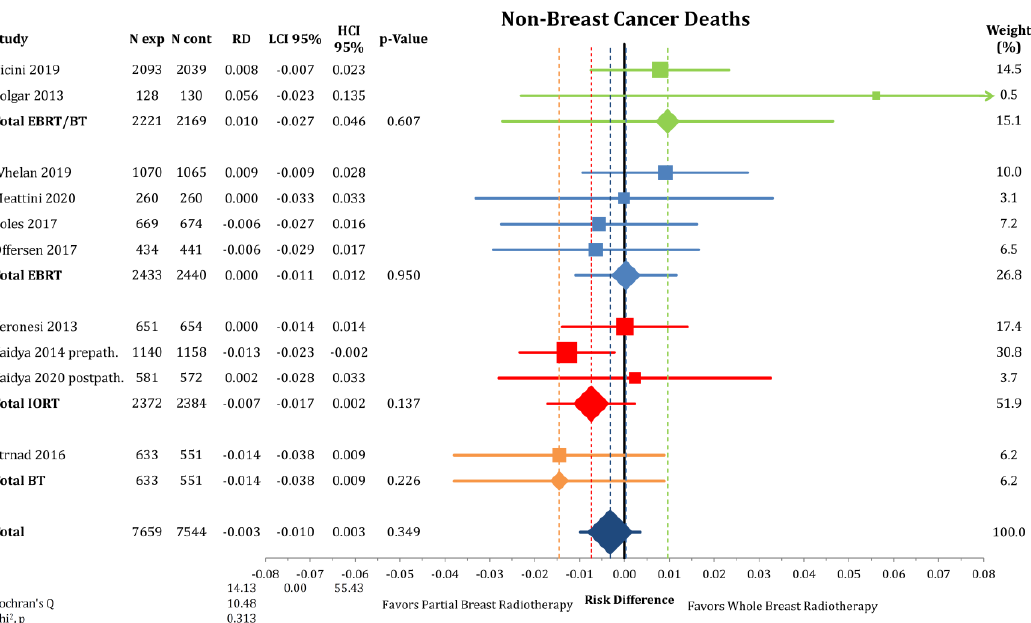
Figure 4. Comparison of breast cancer-specific survival by risk difference between partial- and whole breast radiation using a forest plot and the inverse variance heterogeneity model. Trials are grouped by radiation technique. Quadrats and diamonds represent individual trials and pooled effect sizes with corresponding 95% confidence intervals.